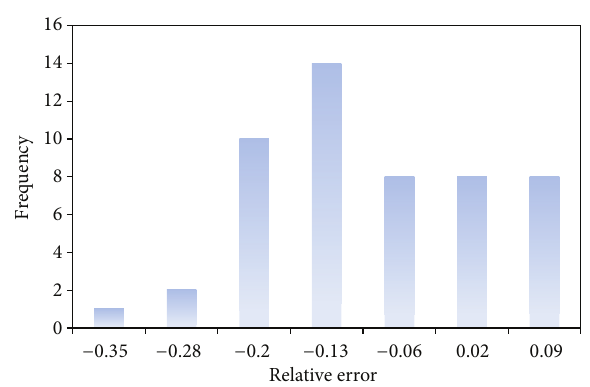
Figure 6: Histogram showing the frequency of the relative errors.